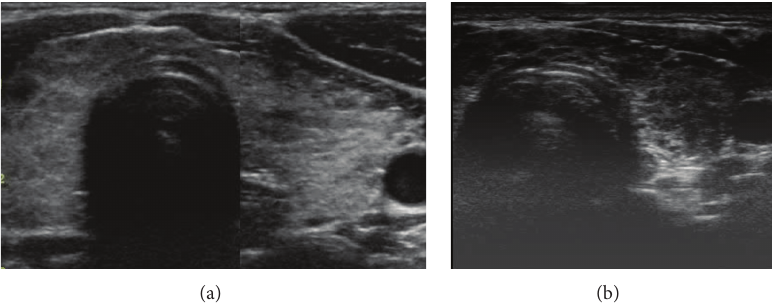
Figure 1: (a) Hashimoto’s thyroiditis with mild sonographic hypoechogenicity. (b) Hashimoto’s thyroiditis with severe sonographic hypoechogenicity.